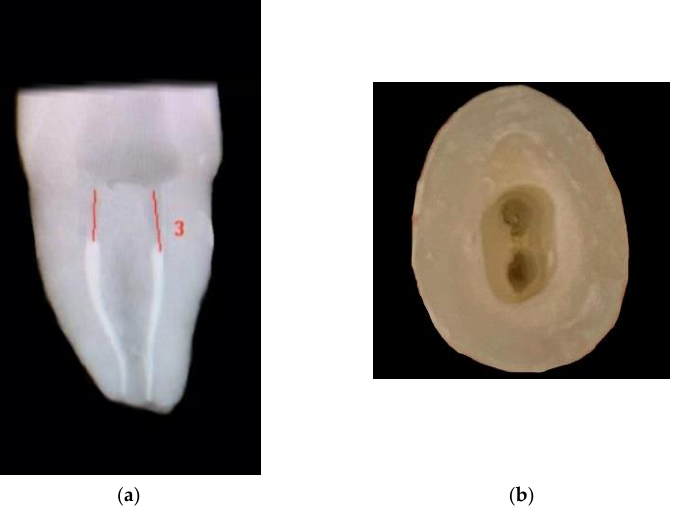
Figure 2. ( a ) Radiographic proximal view of Endocrown preparation with 3 mm intraradicular extension. ( b ) Occlusal view of Endocrown preparation wit 3 mm intraradicular extension.